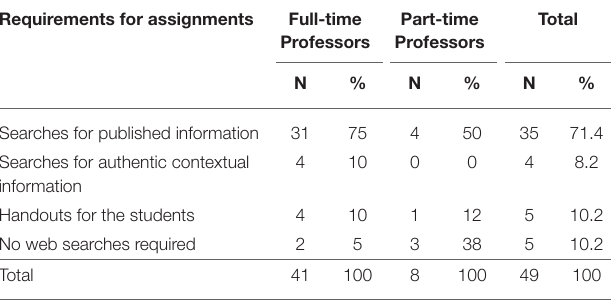
TABLE 3 | Part-time and full-time professors’ requirements for